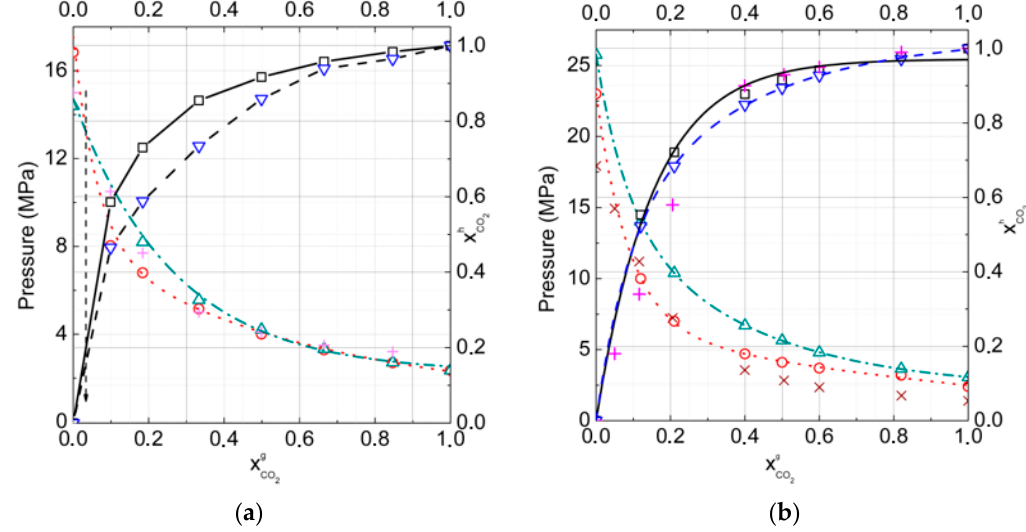
Figure 6. Gas–hydrate–ice (water)phase equilibria for carbon dioxide and nitrogen gas mixtures for cubic structure (CS)-I and CS-II hydrates in comparison with the experimental data, skew crosses [25] and crosses [27], at ( a ) T = 272 K and ( b ) T = 274 K, respectively ( P CS − I eq is dotted by open circles, P CS − II eq is dash-dotted by open triangles, x CS − I is represented by solid open square, and x CS − II is represented by dashed open inverted triangle lines).